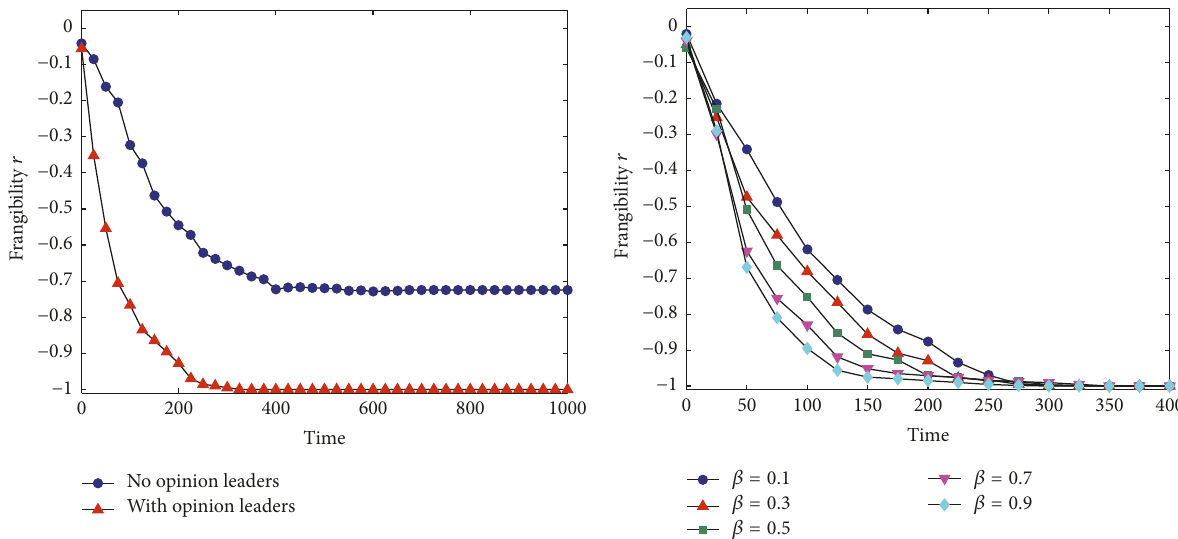
Figure 3: Influence of opinion leaders on the frangibility in social consensus system.